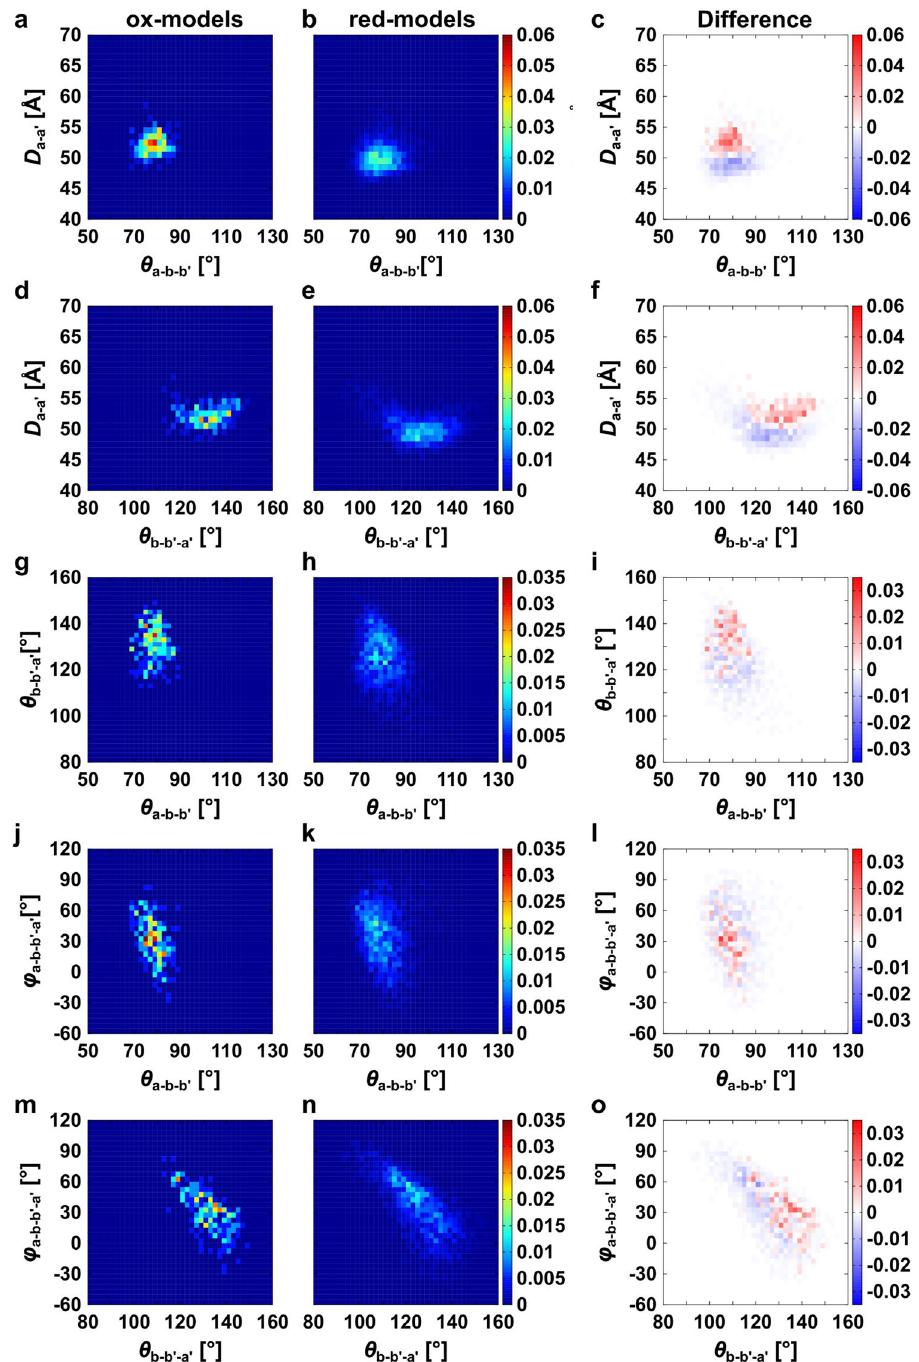
Figure 5. Two-dimensional mapping of the model structures around the a and a ′ domains. Distributions of correlations between two parameters, θ a–b–b ′ — D a–a ′ ( a , b ), θ b–b ′ –a ′ — D a–a ′ ( d , e ), θ a–b–b ′ — θ b–b ′ –a ′ ( g , h ), θ a–b–b ′ —